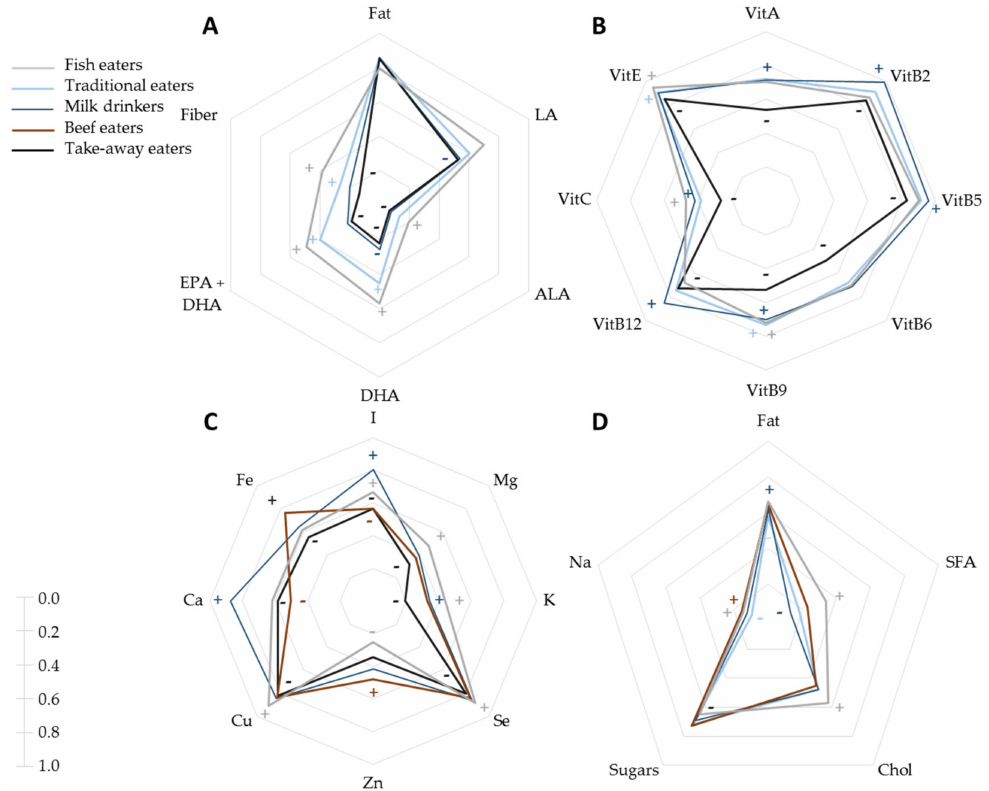
Figure 4. Probabilities of adequacy (PA) for nutrients in the PANDiet score. Only nutrients with a significant association between dietary patterns and PA values, and PA < 0.95 for all patterns, are shown. Significant differences between the PA of a cluster and the PA of the overall sample are represented with a “+” if the PA of the cluster is higher, and a “-“ if the PA of the cluster is lower. The four patterns with the highest number of significant differences are shown in each diagram. A: